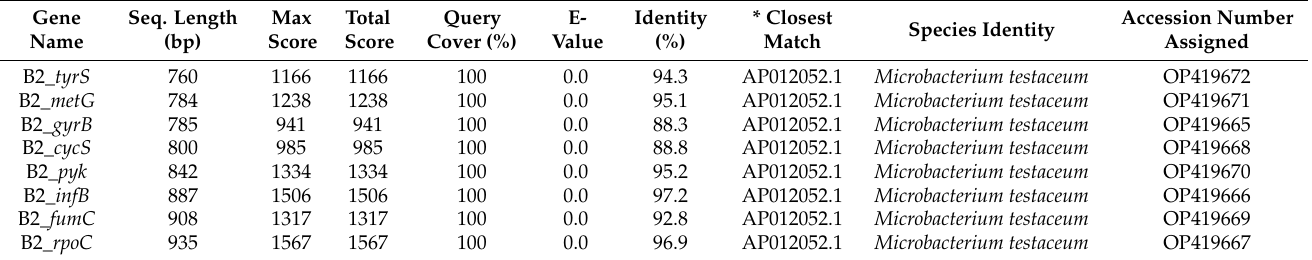
Table 1. Identity of endophytic Microbacterium based on the closest match of multiple gene sequences.